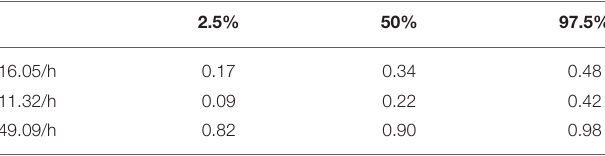
TABLE 6 | 95% confidence intervals for PTT arousal index specificity at the three thresholds (training